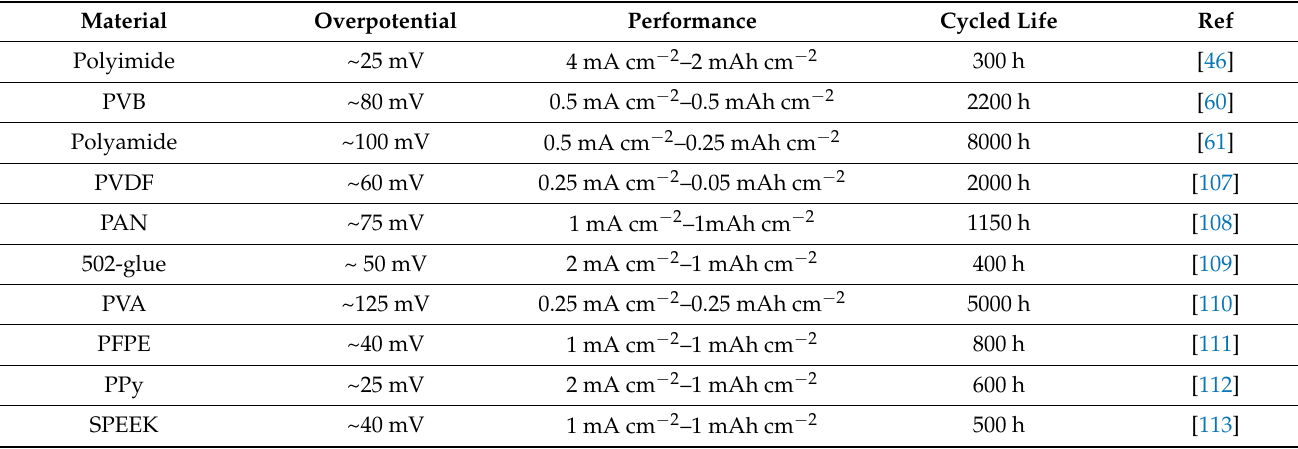
Table 4. Summary of polymers used as coating layers on Zn